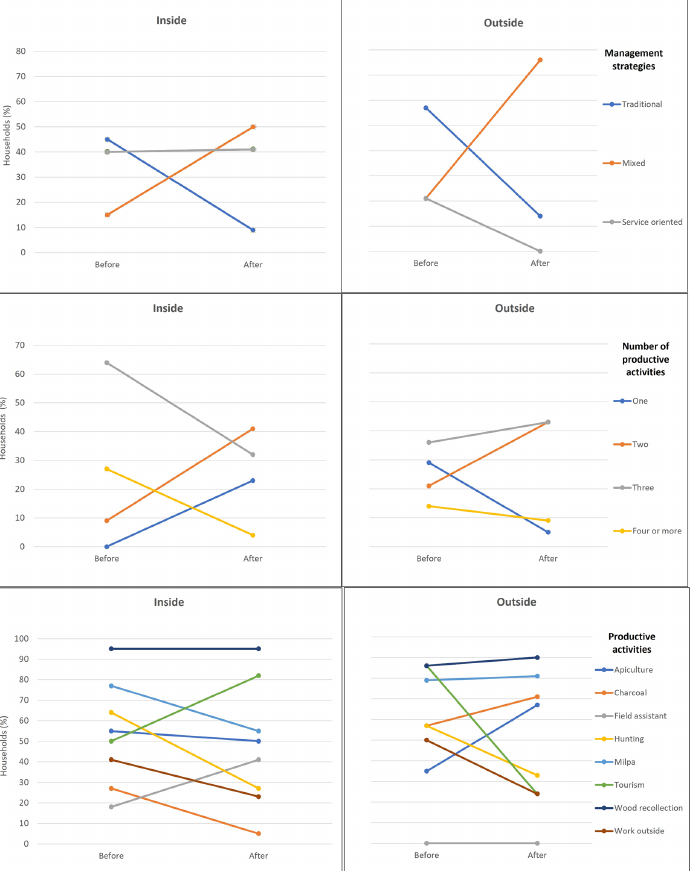
Figure 5. Trends in management strategies (traditional, mixed, or service-oriented); number of ac- tivities per household (one, two, three, four or more); type of productive activities in the communi- ties inside the PA (Punta Laguna) and outside the PA (Campamento Hidalgo), before (2004) and after (2015) its establishment. Values are percentages of total households in each community. Outside the PA, the number of households that reported a traditional management strategy also decreased after the establishment of the PA (from 57% to 14%), whereas households with a mixed strategy tripled (from 21% to 76%). Meanwhile, the number of households reporting a service-oriented strategy dramatically decreased from 21% to 0% (Figure 5). In terms of the number of productive activities reported by households inside the PA, before its establishment, a high proportion implemented three (64%) or more (27%) as part of their management strategy, and none reported only one activity. In contrast, after the establishment of the PA the number of households that reported three or more